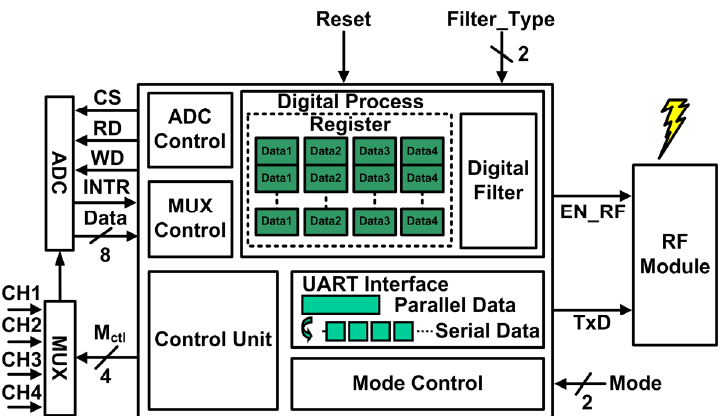
Figure 6. Block diagram of the proposed